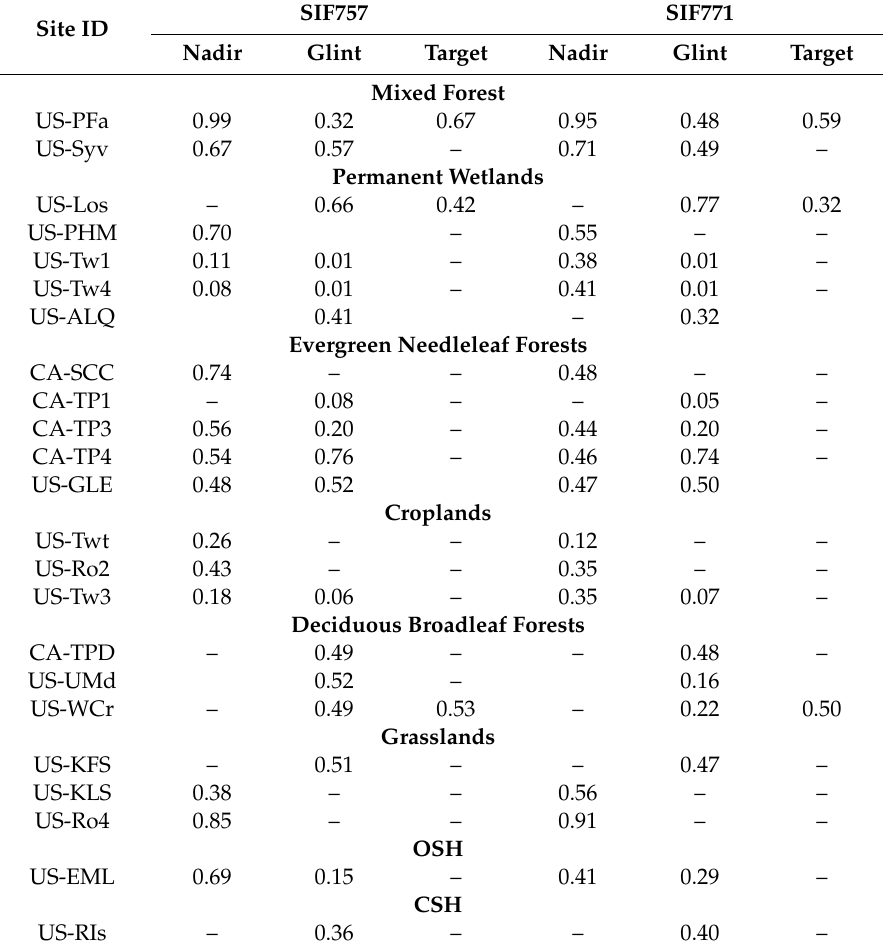
Table 6. Comparisons of correlation coe ffi cients for SIF and EC GPP for the di ff erent observation modes and bands (parameter: R 2